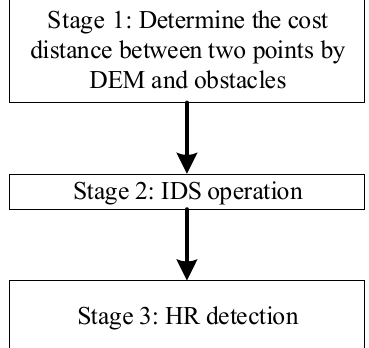
Figure 6. The density-based fuzzy home range estimator (DFHRE) flowchart.